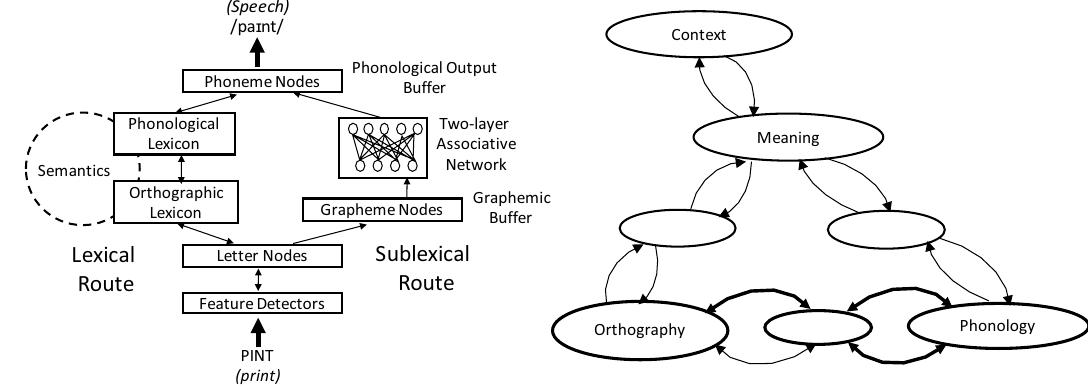
Figure 1. Left side: the CDP model of reading aloud. Right Side: the Triangle